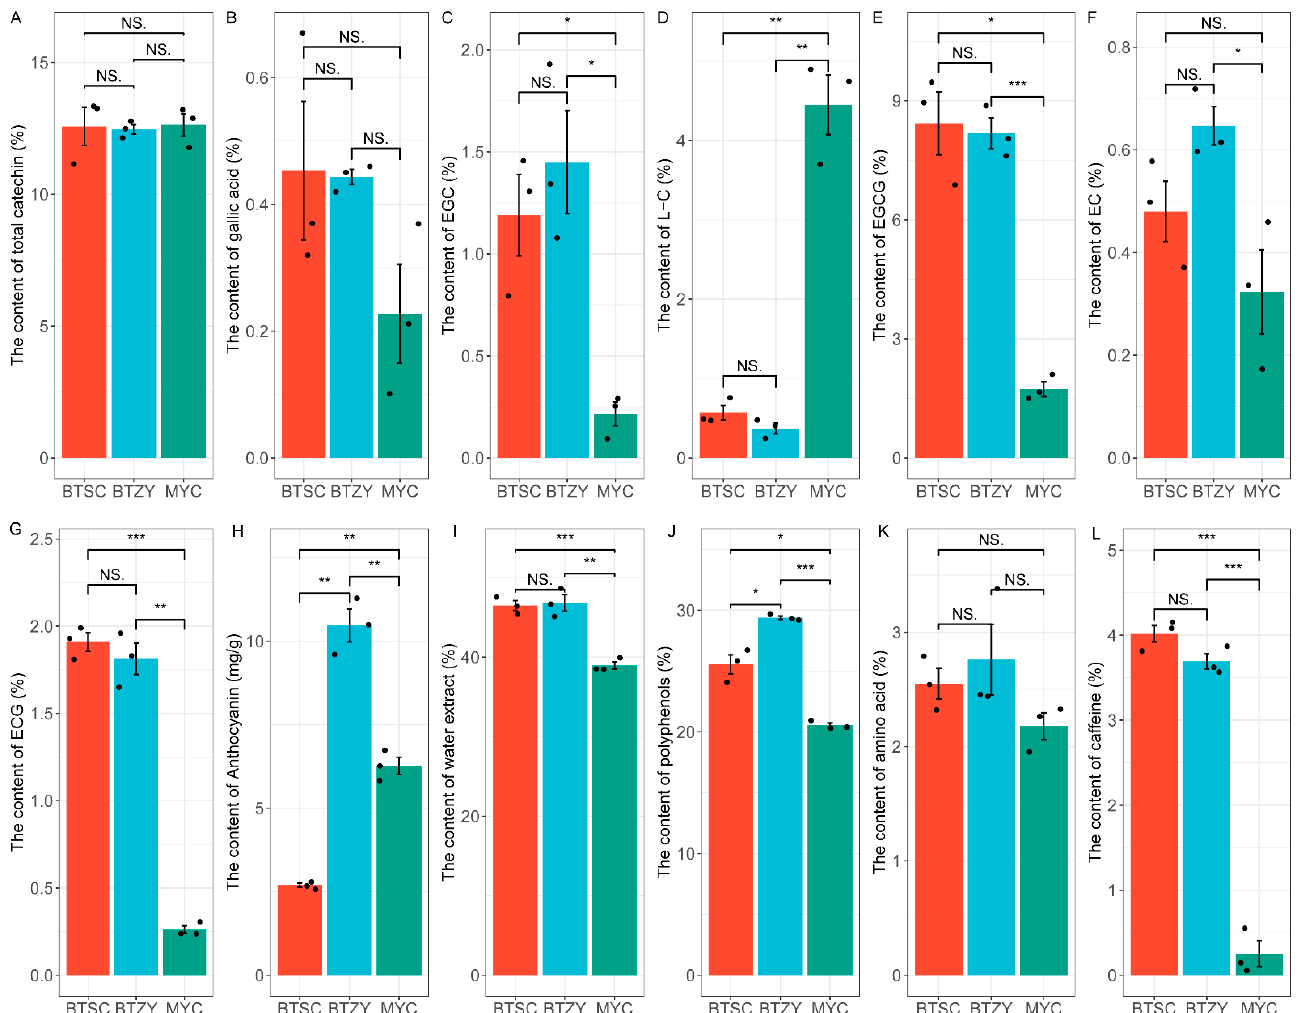
Figure 3. Measurement of bioactive components in three tea plants groups. Differences between mean values of groups were compared using t -tests (“*”: p < 0.05; “**”: p < 0.01; “***”: p < 0.001; NS.: p > 0.05). The black circle refers to the value from various samples.